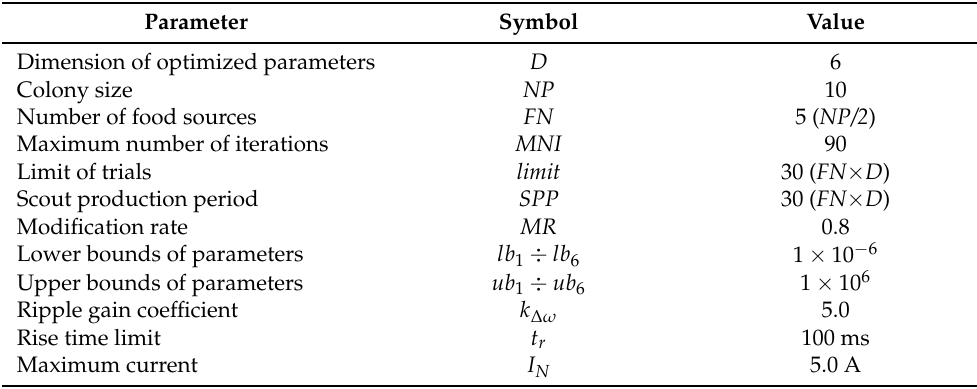
Table 1. Parameters of the ABC tuning